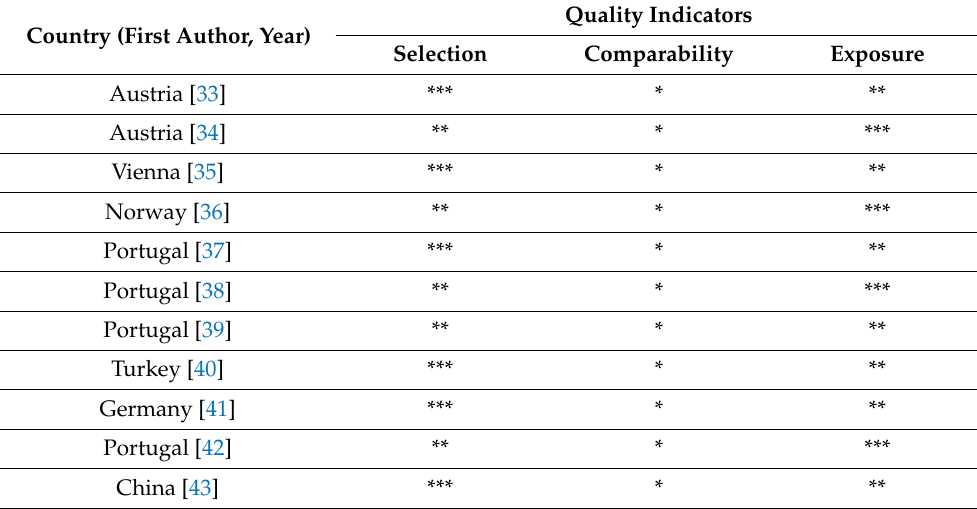
Table 1. Quality assessment of included studies by using the Newcastle–Ottawa Scale.